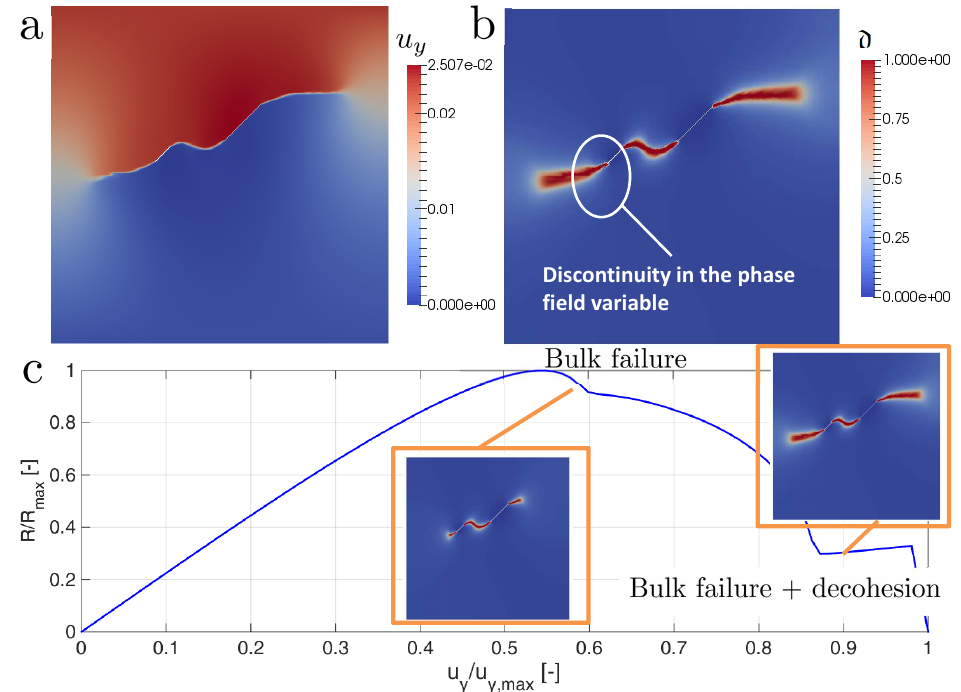
Figure 14. Specimen with 2 inclined flaws and a horizontal joint. Case ¯ u y = 0.5 ¯ u x traction-traction: ( a ) vertical displacement; ( b ) damage pattern; ( c ) Load-displacement evolution curve including snapshots of the phase field variable.